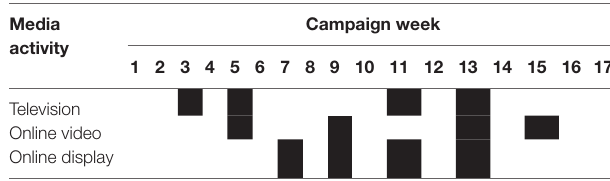
taBlE 1 | Media activity by campaign week.